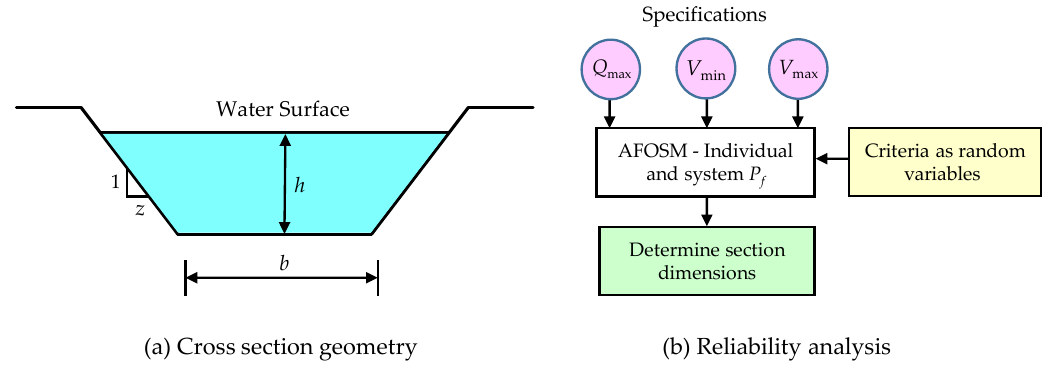
Figure 3. Open channel design using reliability analysis considering three failure modes